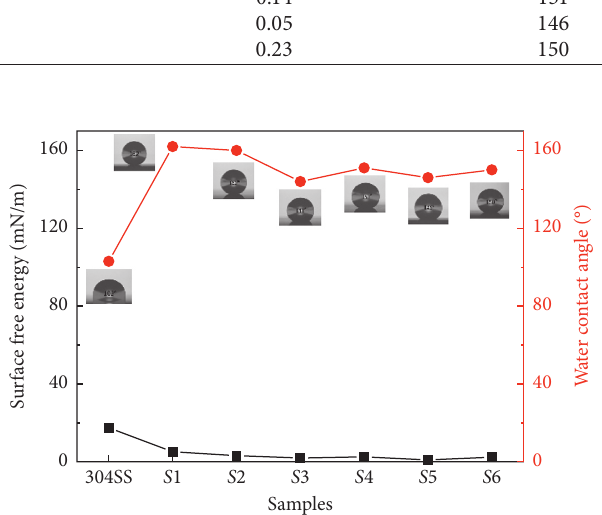
Figure 3: Surface free energies and CAs of laser-treated specimens after fluorination. Table 3: Surface free energy and disperse and polar values before and after